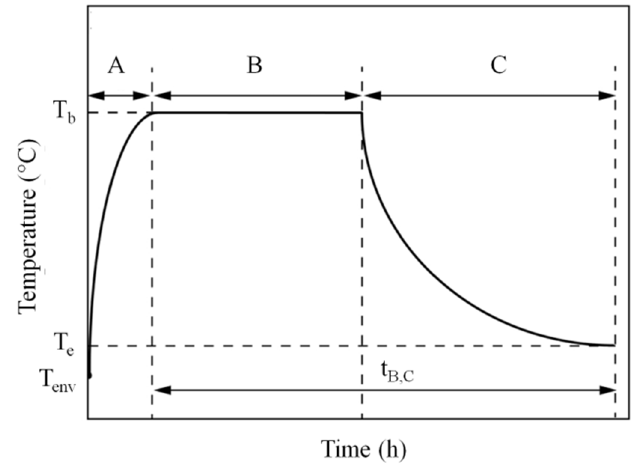
Figure 1. Schematic representation of the temperature profile of a standard SLS process. Adapted from [6].